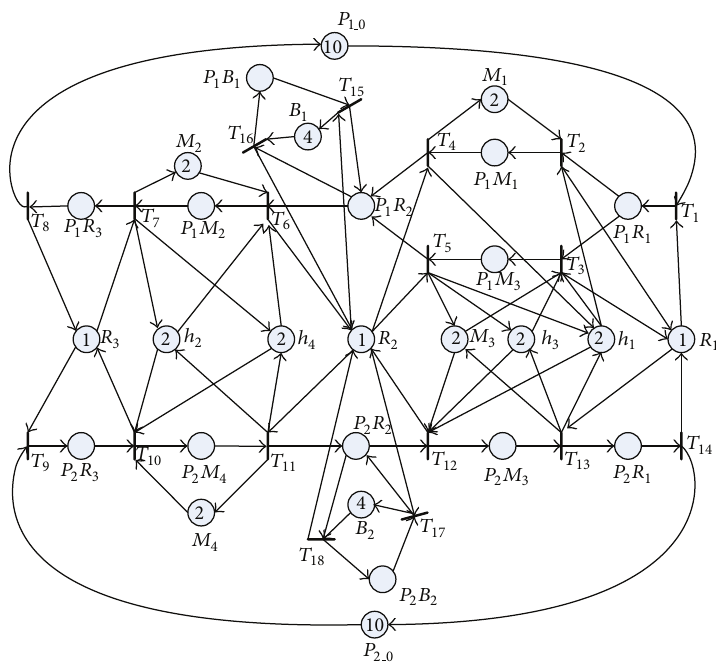
Figure 4: An S ∗ PR net modeling the system in Figure